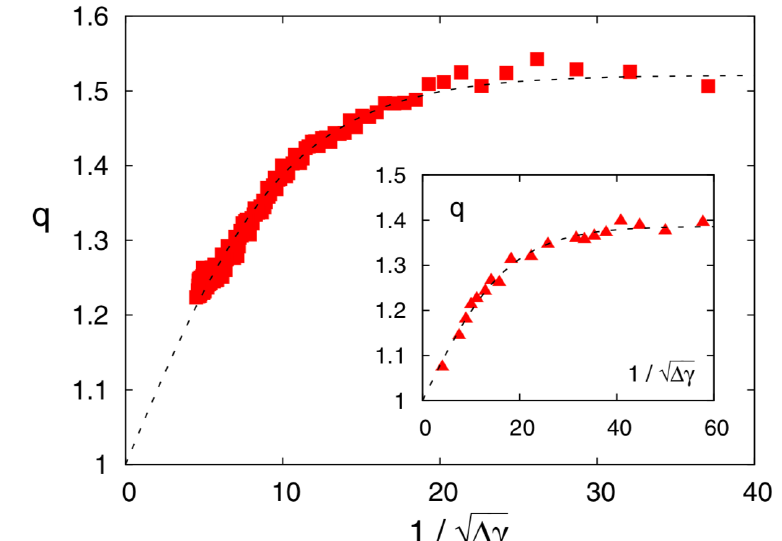
Figure 17. Evolution of the measured value q as a function of the squared inverse of the strain increment for both the experiments and simulations. The dashed line corresponds to a regression √ √ ∆ γ ) = 1 + a tanh ( b / ∆ γ ) , with ( a , b ) = ( 0.521,0.096 ) . Inset : The same using the function q ( 1/ plot for data from a simulation that highlights the limit q = 1 when ∆ γ → ∞ . The fitted parameters for simulations were ( a , b ) = ( 0.387,0.057 ) . From